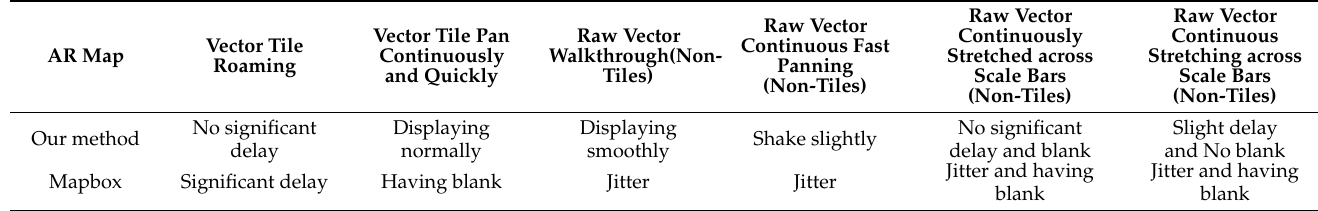
Table 4. Comparison of two full feature vector visualization methods for AR